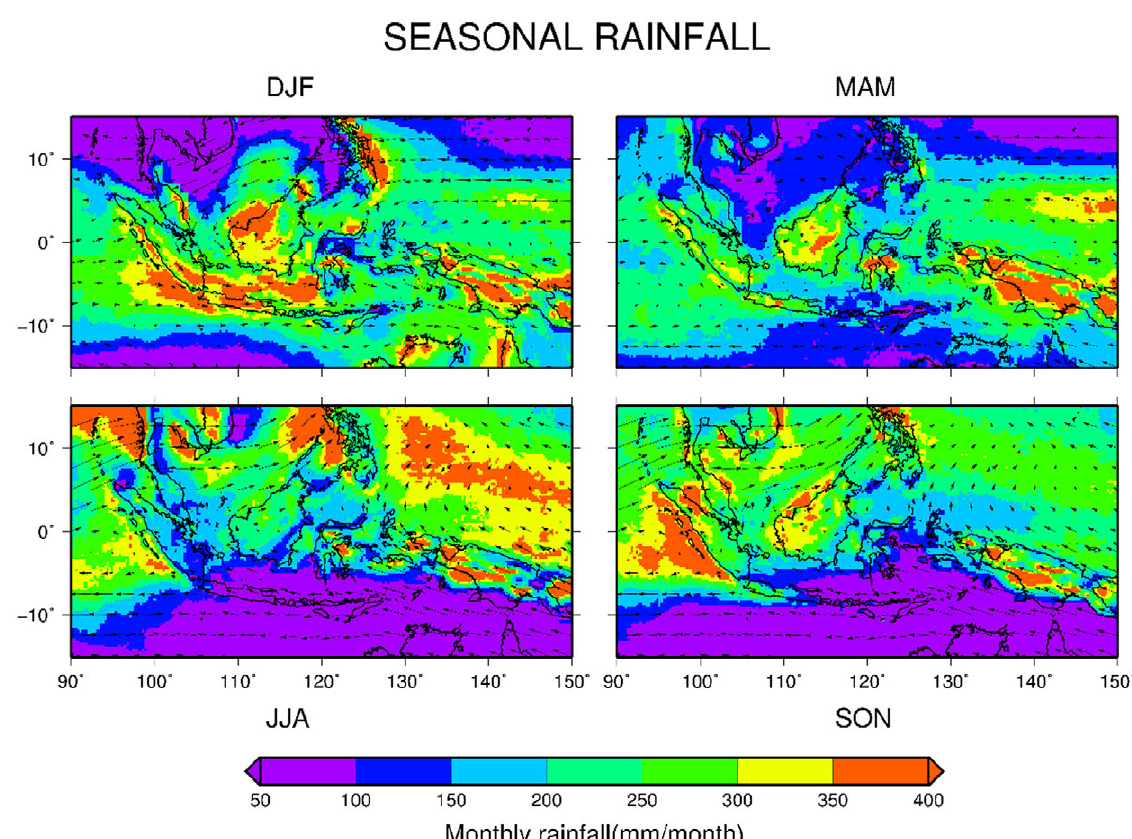
Fig. 2. TRMM 3B42 composite seasonal rainfall and the corresponding NCEP reanalysis horizontal wind vectors from